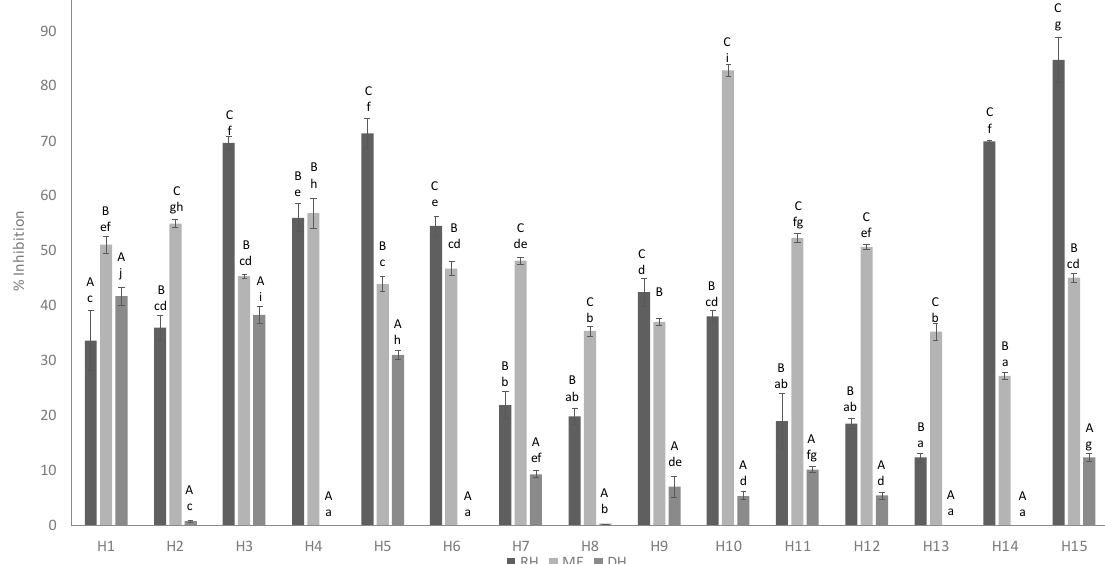
Figure 3. Anti-inflammatory activity of raw honeys (RH), methanolic extracts (ME) and digestive extract (DH). Error bars represent the standard deviation for each data point. Different capitals letters (A–C) indicate significant differences ( p < 0.05) between extractions comparing the same sample. Different lowercase letters (a–g) indicate significant differences ( p < 0.05) between samples with the same extraction.